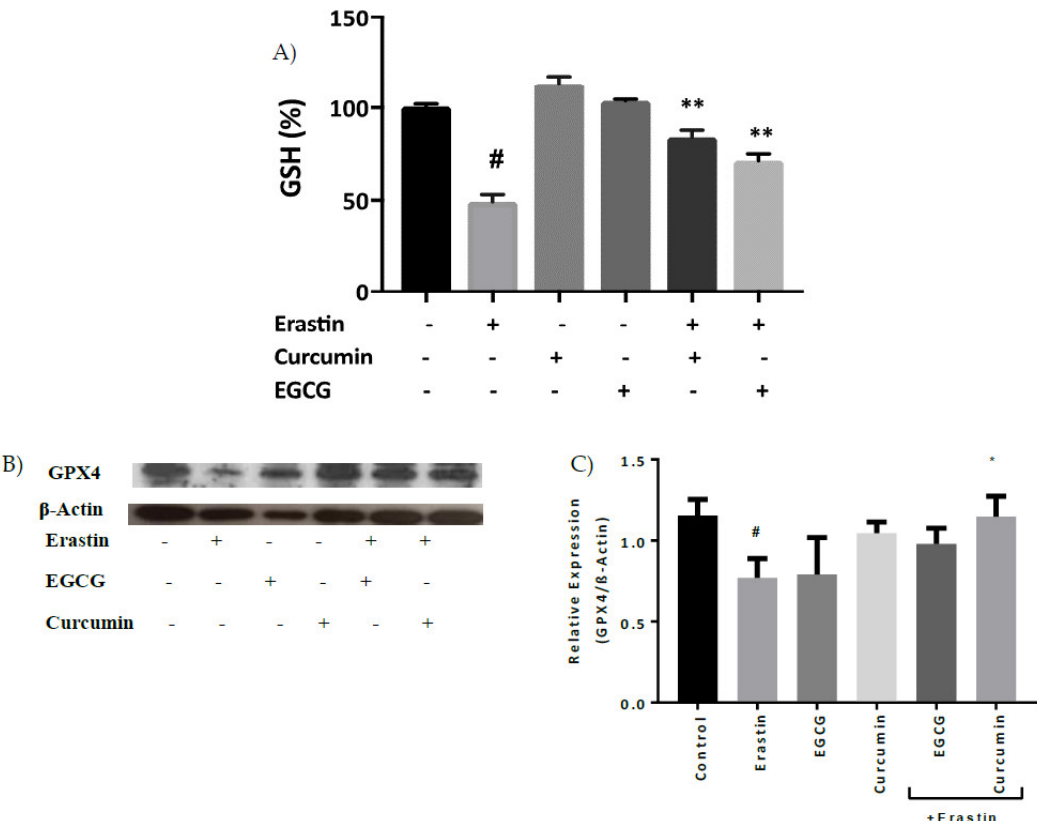
Figure 4. Curcumin and EGCG inhibit GSH depletion in pancreatic cells. Cells were treated overnight with 20 µ M erastin in the absence or presence of curcumin or EGCG. Percentage GSH level is relative to control cell samples. ( A ) Curcumin and EGCG decreased erastin-induced GSH level. ( B ) Western blot analysis showed that curcumin alone significantly suppressed erastin-induced GPX4 level in MIN6 for 24 h. ( C ) Densitometry of Western blots GPX4 protein bands of GPX4. All the values are expressed with the mean ± SEM, n = 3, # p < 0.05 control vs. treatment groups, *p < 0.05 and **p < 0.01 vs. erastin only. One-way ANOVA, Tukey post-hoc test.